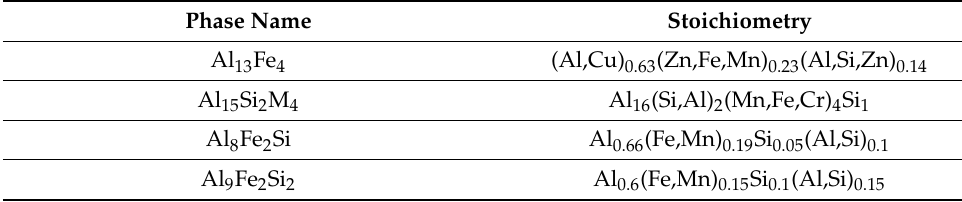
Table 4. Secondary phase stoichiometry from Thermo-Calc